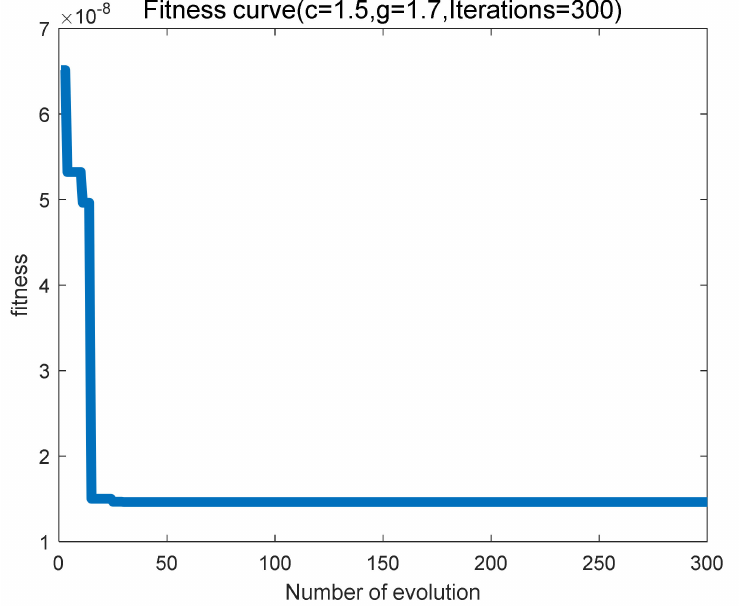
Figure 3. The iterative process of the PSO model for the N15 early warning indicator.